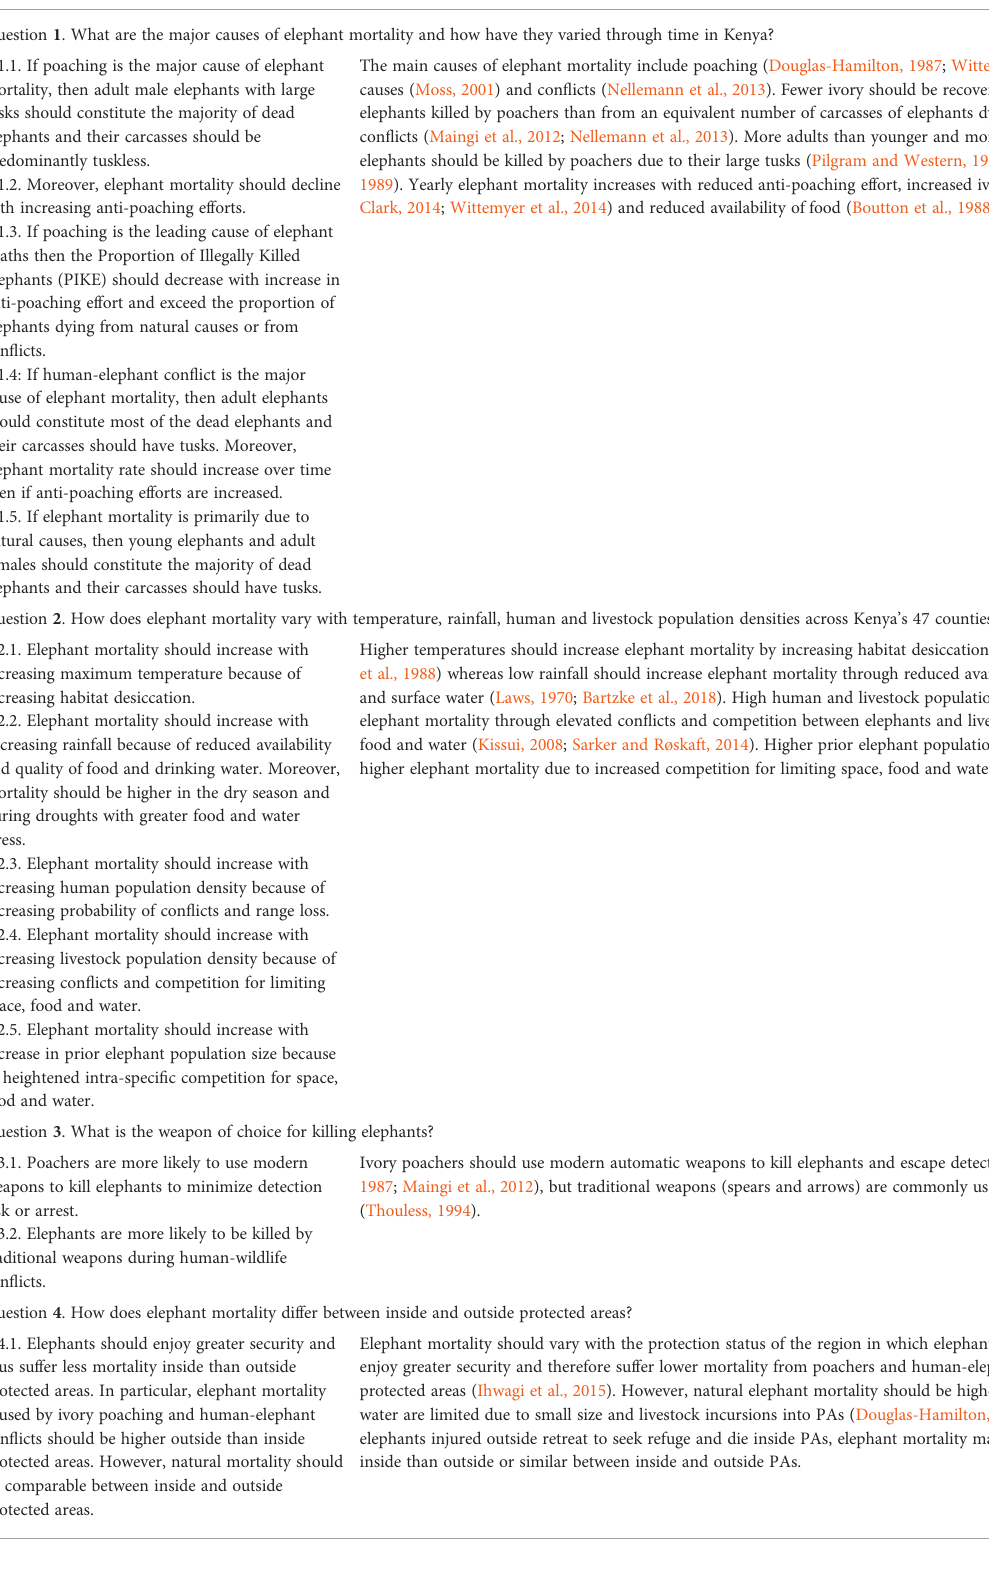
TABLE 1 Hypotheses on long-term elephant mortality in Kenya (1992-2017), their predictions and rationale. Hypotheses and their